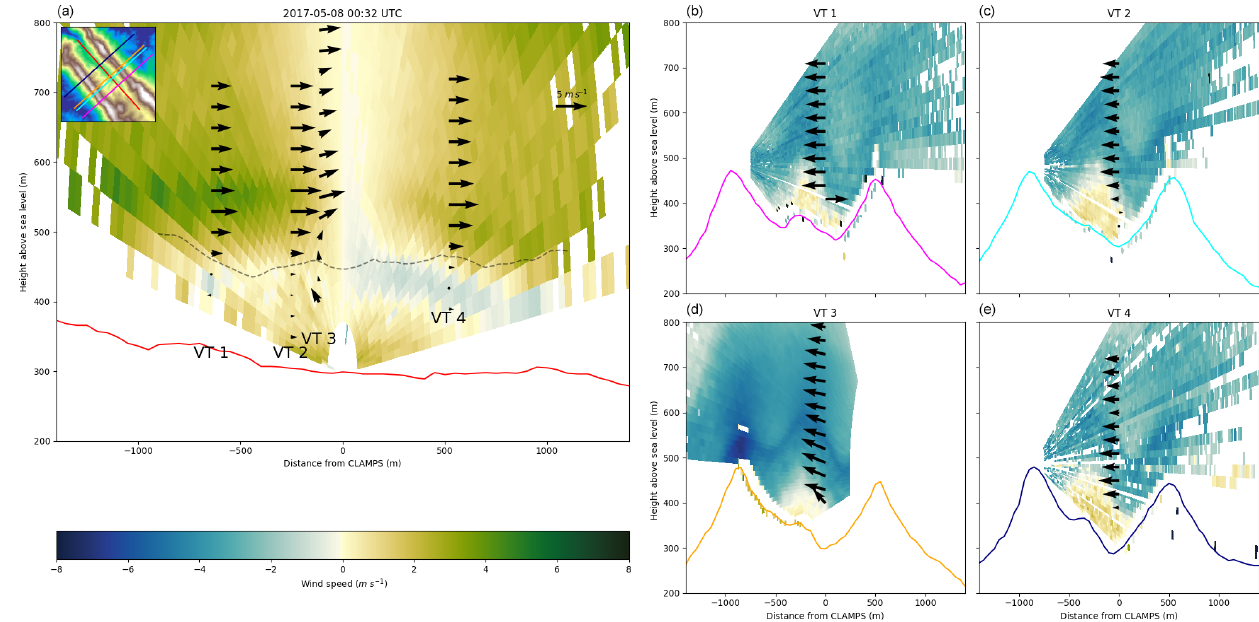
Figure 11. (a) Along-valley cross section of the flow for 8 May at 00:32UTC. The color fill is the radial velocity projected into the horizontal from the CLAMPS RHI used to create the virtual towers. Positive values indicate flow in the + X direction, which is directed to the NW. The overlaid vectors are the components of the virtual towers projected into the plane of the RHI scan, the inset plot shows how the terrain cross sections are oriented and where they are located, and the dashed gray line is the height of the SW ridge. (b–e) Similar to the along-valley plot on the left, only in the cross-valley sense. + X here points to the NE. The color of the line matches the cross section indicated in the terrain inset. This plot corresponds to the profiles shown in Fig. 9.